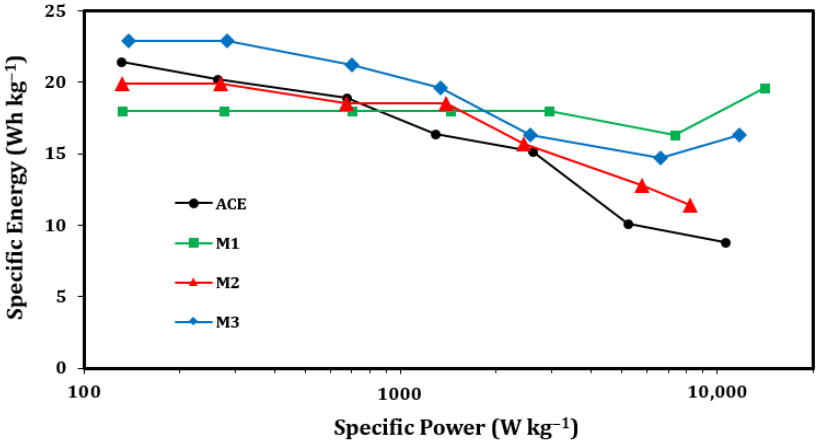
Figure 7. Gravimetric Ragone plot comparing ACE, M1, M2, and M3.